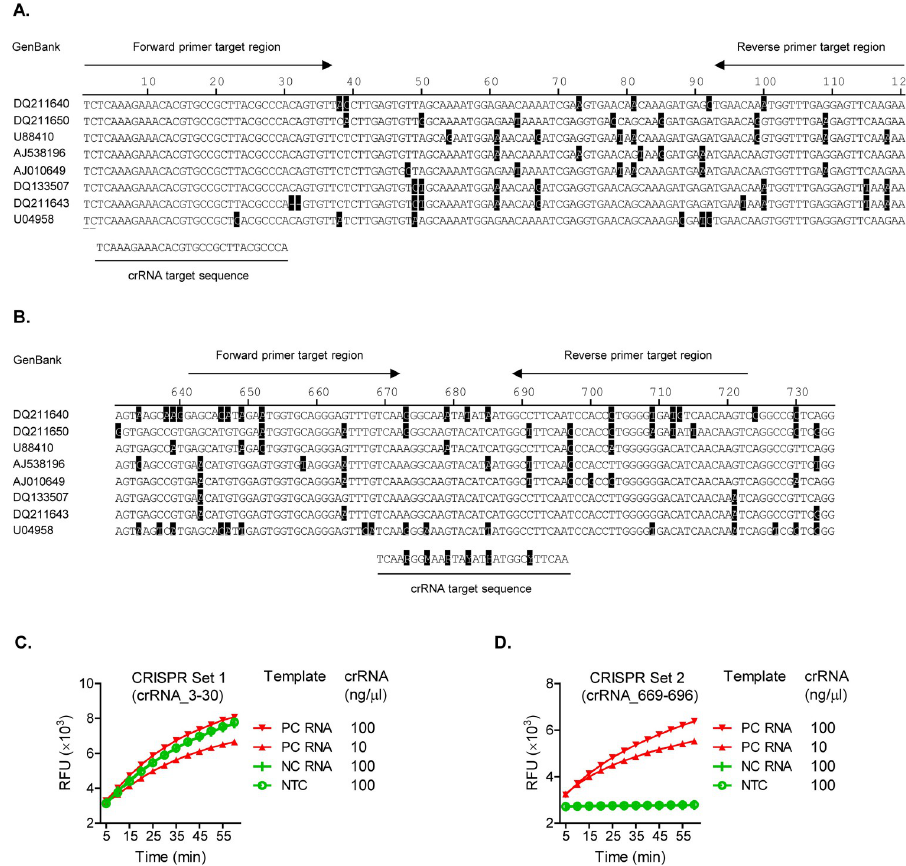
Fig 2. Design and function test of CCHFV CRISPR sets. A and B. Sequences and genomic locations targeted by CCHFV CRISPR sets. The S segment sequences of CCHFV strains, labelled with GenBank accession numbers, were aligned at the assay design regions for CRISPR set 1 (in Panel A) and CRISPR set 2 (in Panel B). Nucleotides differing from the majority are highlighted in dark shades. Sequences and locations targeted by RT-RPA primers and crRNAs are indicated, based on the positive-sense sequence of the S segment. The CCHFV strains, representing each of all the seven clades/sub-clades, are detailed in Table 1, except that a Clade V variant, DQ211643, with a two-nucleotide deletion at genomic positions 31 and 32 is included only in this figure. Note that degenerate nucleotides were introduced into the crRNA of CRISPR set 2, to cover variations at each position in the targets, and are displayed with the standard codes by International Union of Pure and Applied Chemistry (IUPAC). C and D. Specific signal amplification by CRISPR Set 2, but not CRISPR set 1. The CRISPR sets were tested in the CRISPR/Cas13a-based SHERLOCK assay, in the presence of chemically synthesized CCHFV RNA fragments and different concentrations of stock crRNAs. Sequences of RT-RPA primers, crRNAs and synthetic RNA templates are listed in Table 2. Amplification plots show relative fluorescent units (RFU) at indicated time points in the T7-Cas13a reaction. C. Test of CRISPR set 1 (with constant crRNA spacer). PC RNA (positive control RNA, specific target) = Target_RNA_1–120; NC RNA (negative control RNA, non-specific target) = Target RNA_641–723. NTC (no-template control) = H2O. Graph represents five independent experiments showing similar patterns. D. Test of CRISPR set 2 (with degenerate crRNA spacer). PC RNA = Target RNA_641–723; NC RNA = Target_RNA_1–120. NTC = H2O. Graph represents four independent experiments showing similar